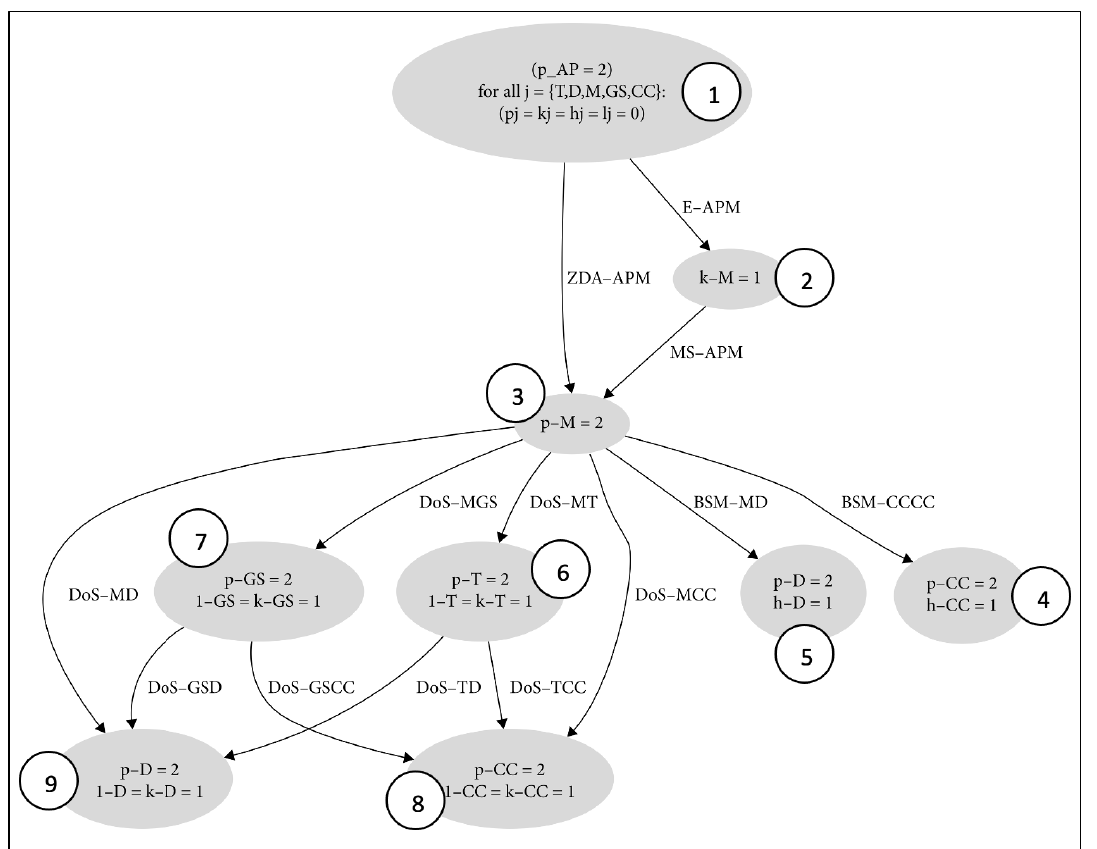
Figure 2. Smart grid ’ s attack graph.